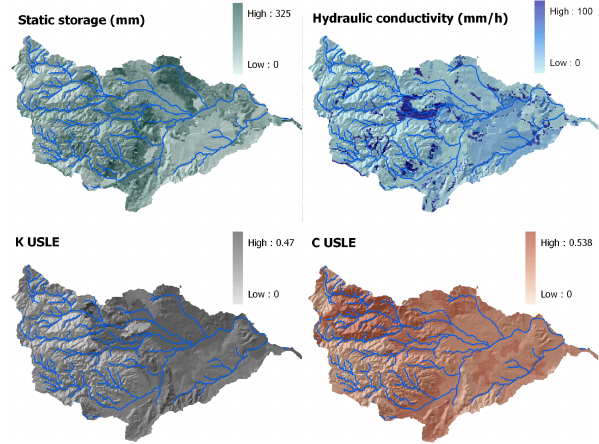
Fig. 3. Maps of the most influent model